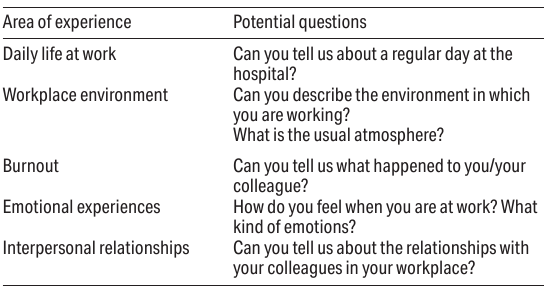
Table 2. Interview